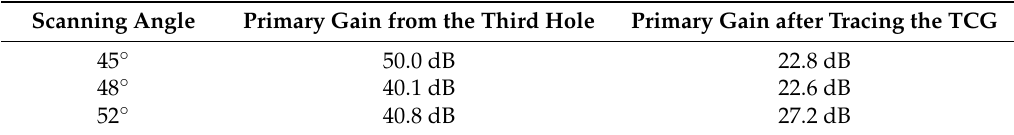
Table 9. Primary gain from the third hole after TCG adjustment for scanning angles of 45 ◦ , 48 ◦ and 52 ◦